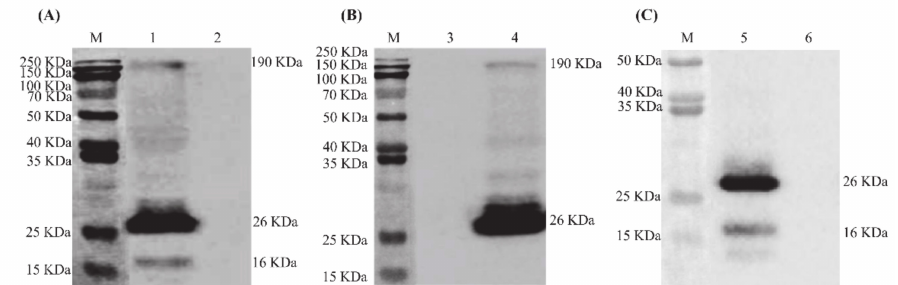
Figure 3. Western blot analysis of virus-like particles (VLPs). ( A ) Western blot analysis of SME- VLPs purified from culture supernatants of cells co-infected with rHBM-S, rHBM-M and rHBM-E. ( B ) Western blot analysis of SM-VLPs purified from culture supernatants of cells co-infected with rHBM-S and rHBM-M. ( C ) Western blot analysis of ME-VLPs purified from culture supernatants of cells co-infected with rHBM-M and rHBM-E. Lane M, protein molecular weight marker; Lane 1, purified VLPs containing S, M and E proteins; Lane 4, purified VLPs containing S and M proteins; Lane 5, purified VLPs containing M and E proteins; Lanes 2, 3 and 6, wild-type